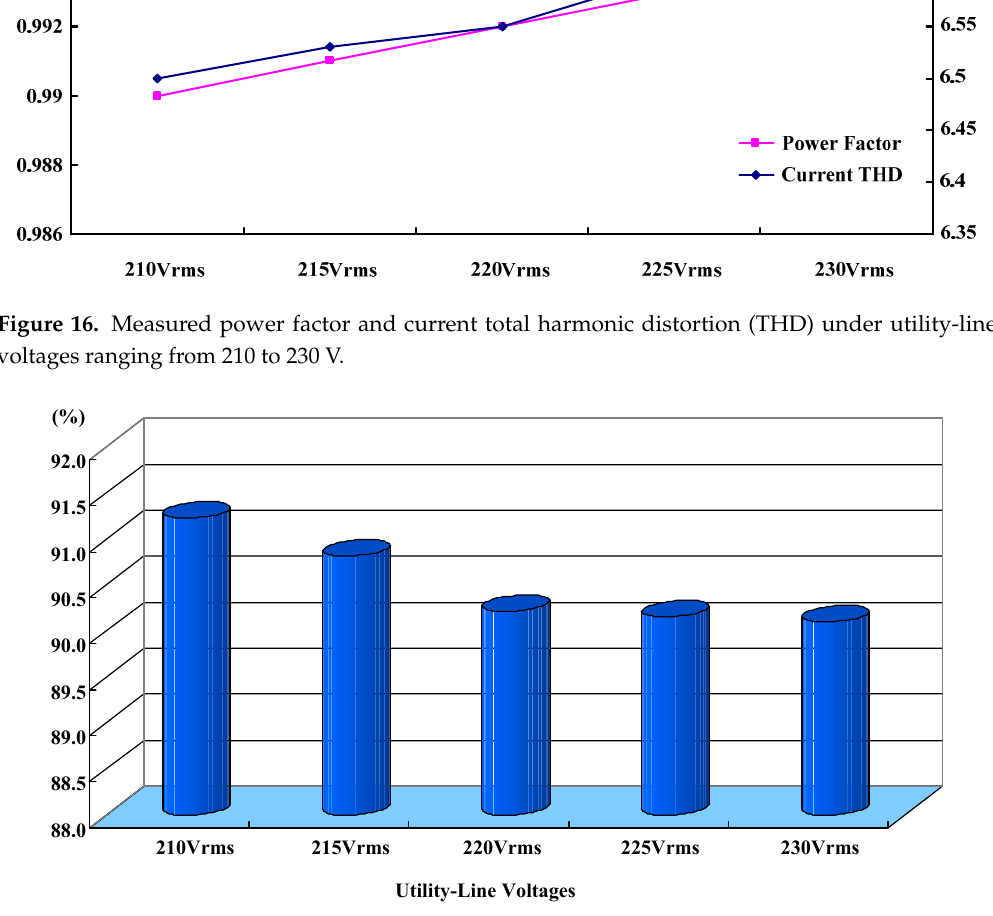
Figure 17. Measured circuit efficiency under utility-line voltages ranging from 210 to 230 V.